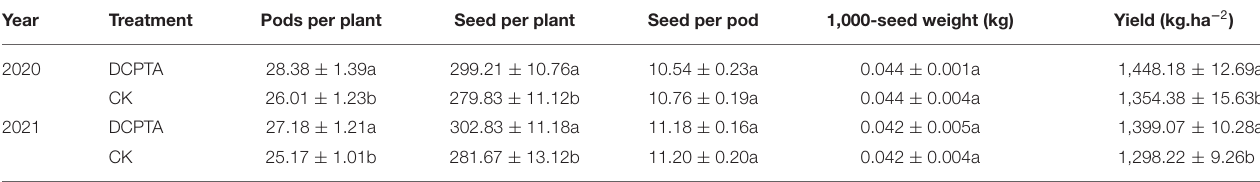
TABLE 2 | Effects of DCPTA on mung bean grain yield and yield components from 2020 to